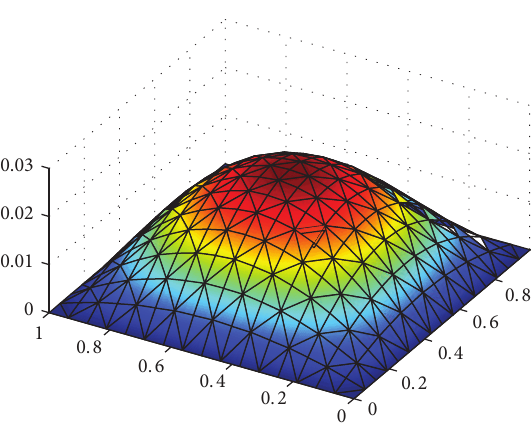
Figure 2: Surface for numerical solution 𝑢 ℎ